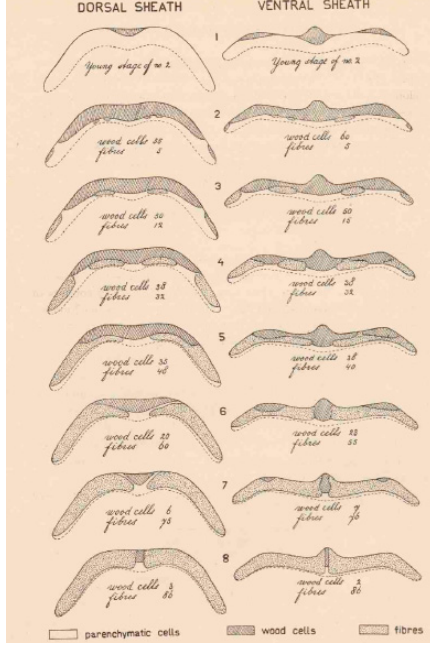
Figure 5. Illustration of the pod fiber content in stringless and stringy common bean varieties. Dorsal ( left ) and ventral ( right ) sheats of pods of stringy type Wagenaar (8 in the Figure), stringless type Fijne tros (2 and 3 in the Figure), intermediate F1 plants obtained after the cross between Wagenaar and Fijine tros (4, 5, and 6 in the Figure), and young pods of variety Fjine tros (1 in the Figure). The Figure shows the distribution of parenchymatic (i.e., non lignified), wood (i.e., lignified but not thickened), and fiber (i.e., lignified and heavily thickened) cells. The percentage of fiber and wood cells is shown for each pod type below the corresponding drawns (from Prakken [26]). Genes 2019 , 10 FOR PEER REVIEW